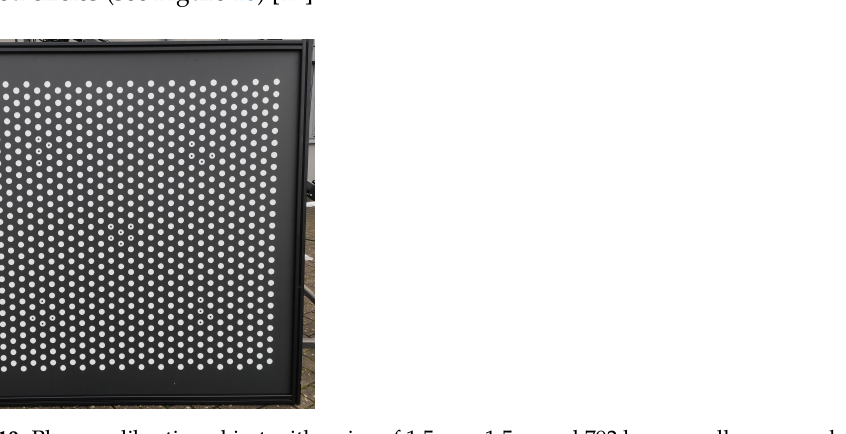
Figure 10. Planar calibration object with a size of 1.5m × 1.5m and 792 hexagonally arranged